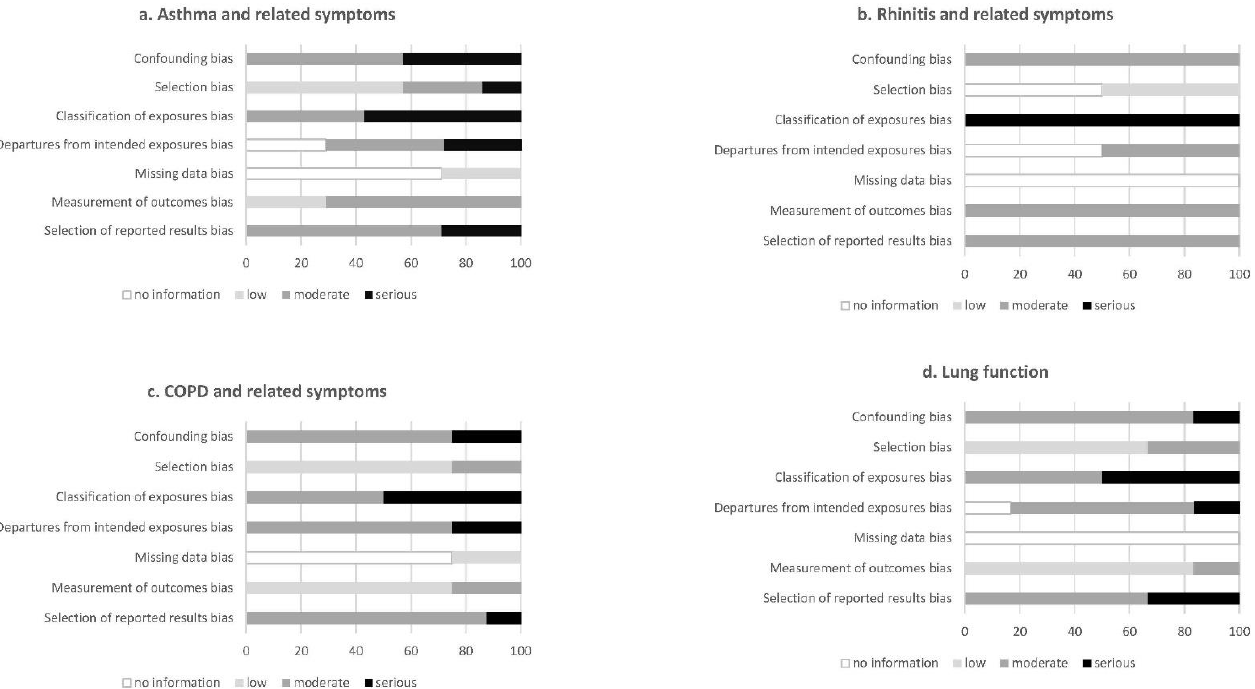
Figure 2. Risk of bias in individual studies, showing the proportion of studies with no information and low, moderate and serious risks of bias in each domain of the RoB-NObs tool: ( a ) asthma and related symptoms, ( b ) rhinitis and related symptoms, ( c ) COPD and related symptoms and ( d ) lung function.